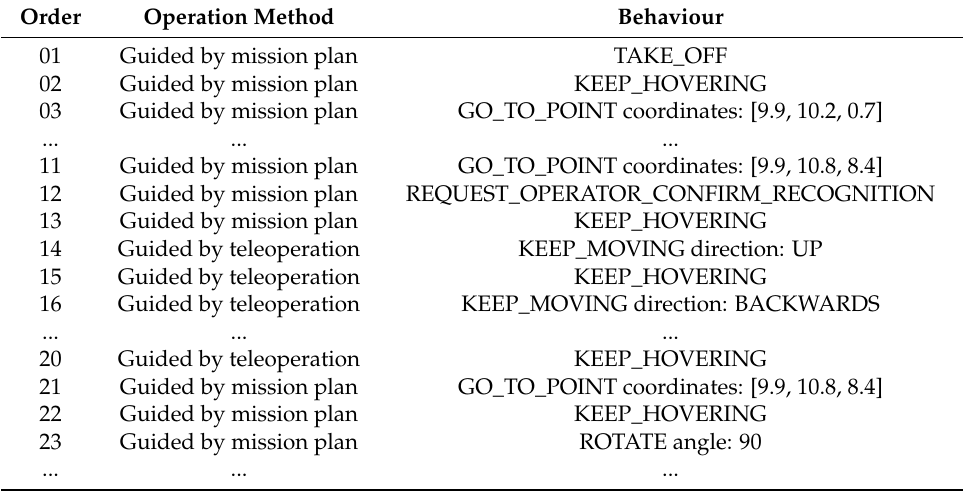
Table 3. Partial sequence of behaviour